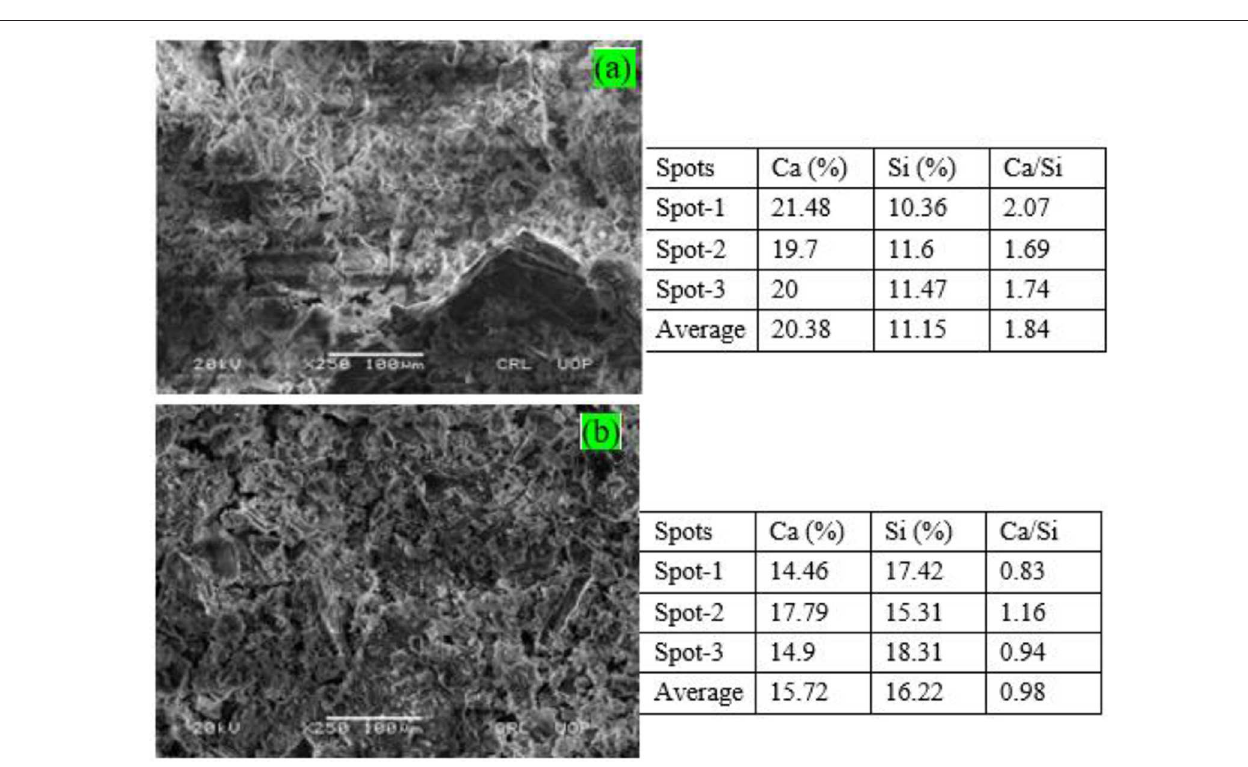
Frontiers in Materials |